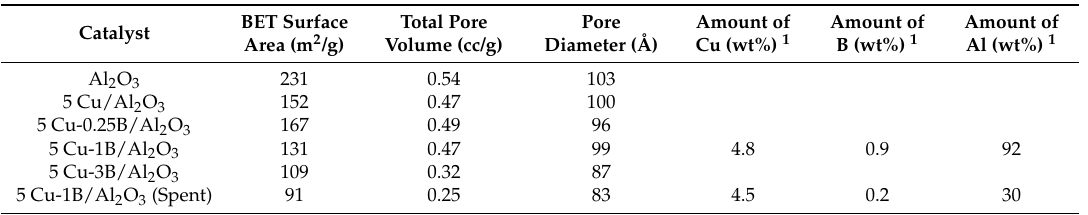
Table 1. Textural properties of the fresh/spent Cu/Al 2 O 3 catalysts loaded with various amounts of B 2 O 3 determined by N 2 adsorption-desorption.